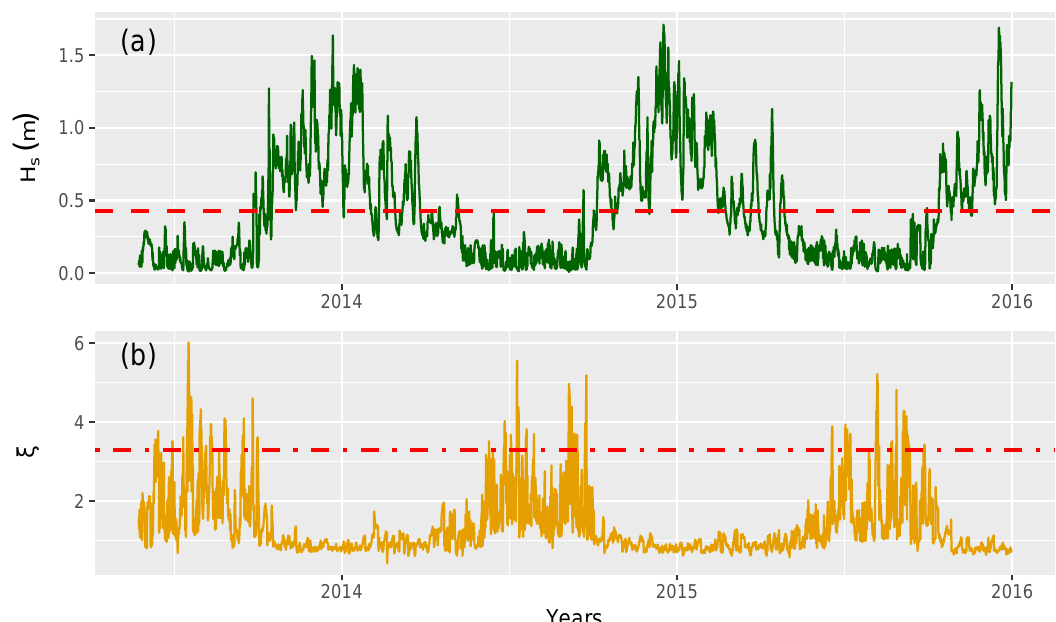
Figure 7. ( a ) Time series of SWAN significant wave height H s at 10m depth (green line) and the horizontal line at its mean value = 0.43m (red dashed line). ( b ) Time series of the surf similarity parameter ξ (yellow line) and the horizontal line at the threshold value of ξ = 3.3 (red dashed line).